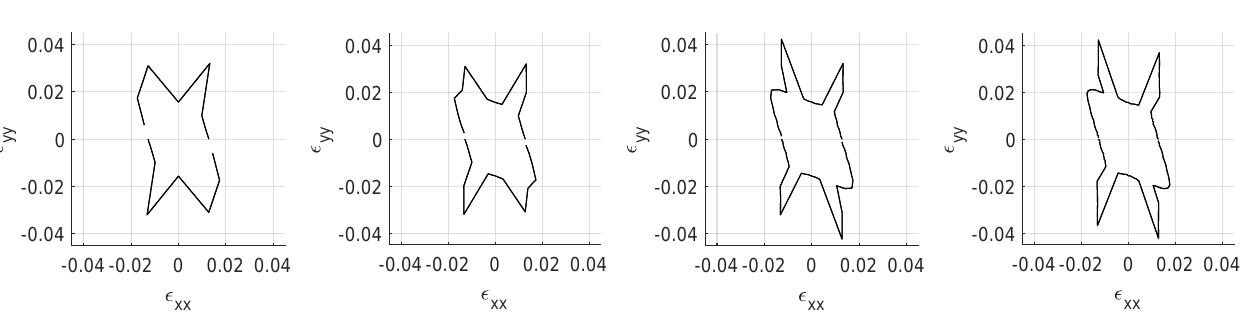
Figure 12. Failure surfaces for different function resolutions. From left to right: 8–16–32–64 points. These are utilized as target functions to evaluate the goodness of fit of the optimiza- tions. Objective functions correspond to the Top (or Macro-) level emerging constitutive response and the Bottom (or micro-) level is optimized based on them. The used resolutions are 8, 16, 32 and 64 points for half of the (cid:101) 11 – (cid:101) 22 space. Due to the nature of the